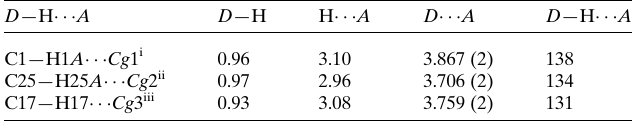
Table 1 Hydrogen-bond geometry (A˚ , (cid:2) ).